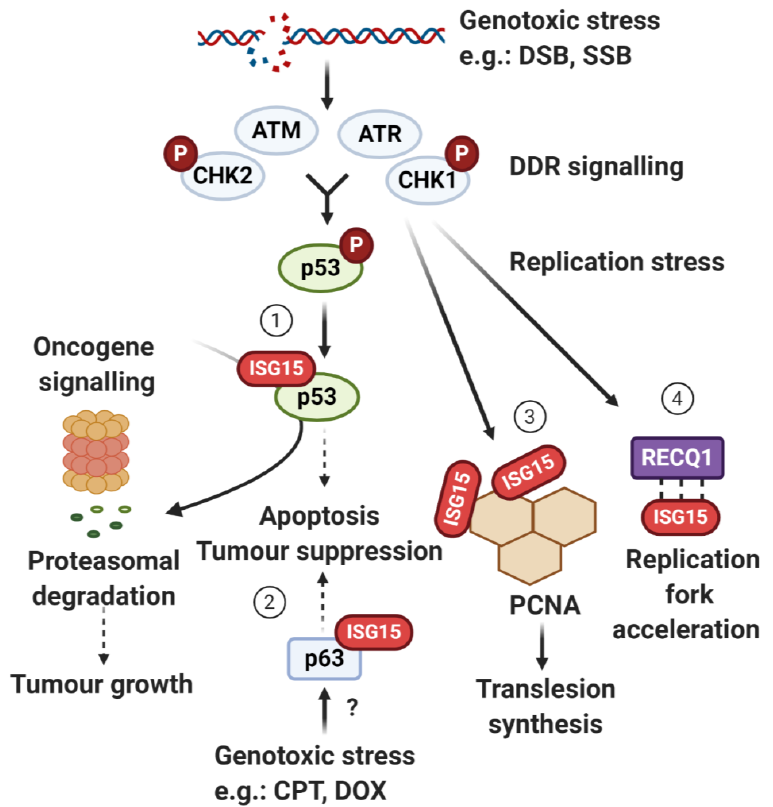
Figure 4. Key aspects of the DNA damage response (DDR) and associated pathways regulated by ISG15. Following exposure to genotoxic stress, DDR signalling is initiated via the activation of apical DDR kinases including ATM and ATR and their targets CHK2 and CHK1, respectively, which in turn activate downstream pathways, such as p53-mediated apoptosis and tumour suppression, or processes that facilitate DNA replication past lesions including translesion DNA synthesis and regulation of replication fork progression. ISG15 intersects with these pathways at multiple points: (1) DNA damage-induced activation of p53 induces the expression of the ISG15 system. ISGylation of p53 in multiple positions can target p53 for proteasomal degradation to promote tumour growth, or, alternatively, mediate cell-cycle arrest, apoptotic responses and ultimately tumour suppression de- pending on the exact circumstances. ISGylation of p53 has also been linked to oncogene-mediated transformation by targeting p53 for degradation via the 20S proteasome. (2) In order to prevent tu- mourigenesis, genotoxic stress caused by chemotherapeutic drugs can stimulate ISGylation of p63 isoforms independently of p53 through yet not fully understood mechanisms. In addition, ISGyla- tion of PCNA (3) and non-covalent interaction of ISG15 with RECQ1 (4) function in translesion DNA synthesis and replication fork acceleration, respectively, in cells undergoing replicative stress.